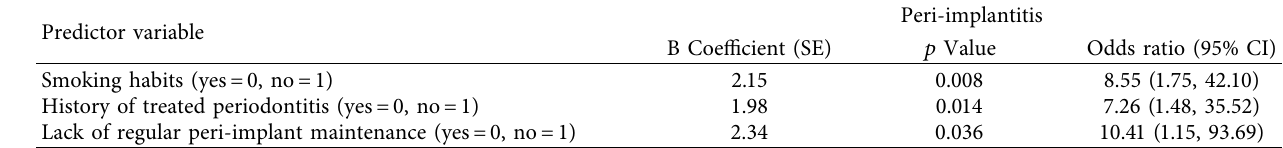
Table 5: Results of logistic regression